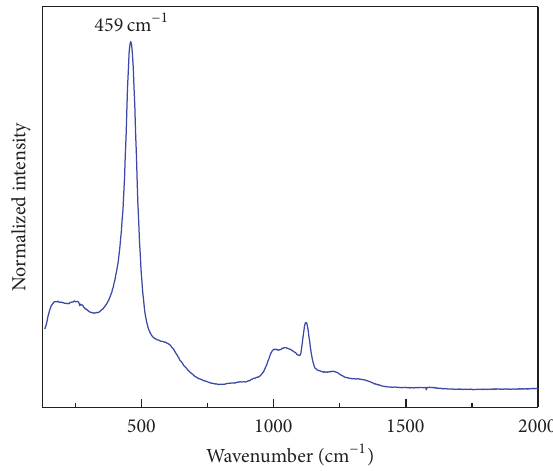
Figure 6: Raman spectra of a CeO 2 /MMT nanocomposite elec- trodeposited film using potentiostatic conditions at 𝐸 = 1.10V and 25 ∘ C.